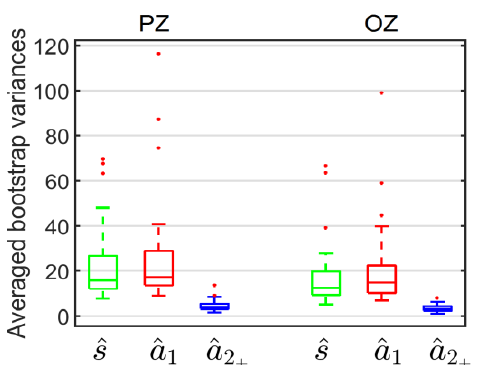
Figure 5 Averaged bootstrap variances of the ERP at image onset 𝑠̂(𝑡) , the EFRP at the first fixation 𝑎̂ 1 (𝑡) and at the second and subsequent fixations 𝑎̂ 2 (𝑡) , estimated by the three- + class GLM, on PZ and OZ